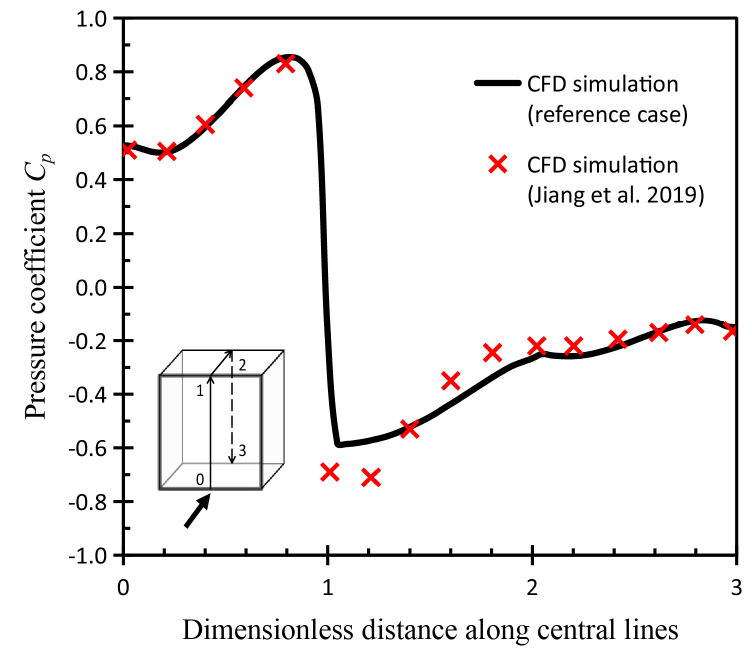
Figure 9. Comparison of wind pressure coefficient C p distribution. Table 1. Comparison of average value of normalized velocity U / U ref and wind pressure coefficient C p on measurement lines.